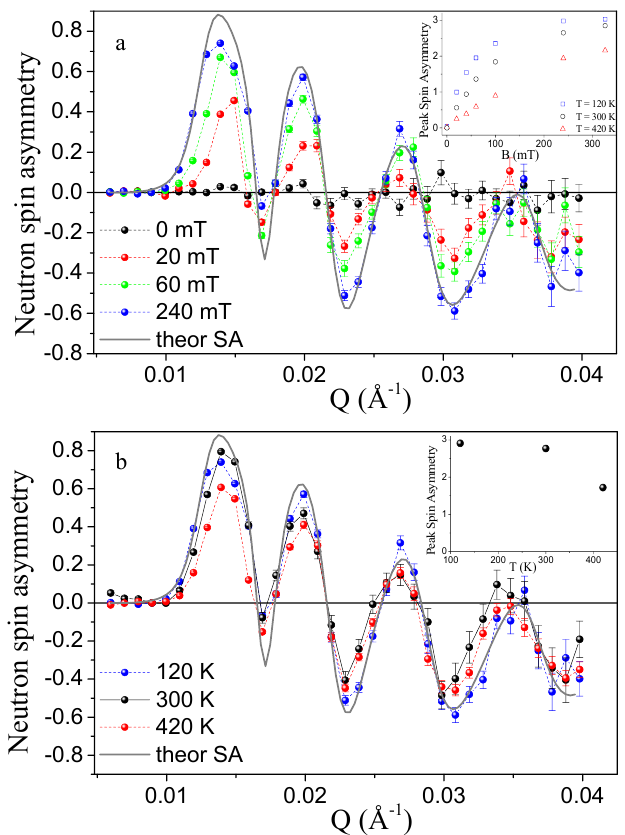
Figure 10. The neutron spin asymmetry, SA, for Au/SiO 2 (70 at.% Co)/Si fitted (gray line) to the chemical and magnetic model previously described in the text (Figure 7): ( a )—under applied magnetic fields up to 320 mT, ( b )—for different temperatures at B = 240 mT. Insert in panel ( a )—the field-dependence of the integral intensity of the peak spin asymmetry for different temperatures. Insert in panel ( b )—the temperature dependence of the integral intensity of the peak spin asymmetry at B = 240 mT. For clarity, data for ( a ) at B = 40, 100, and 320 mT are omitted.